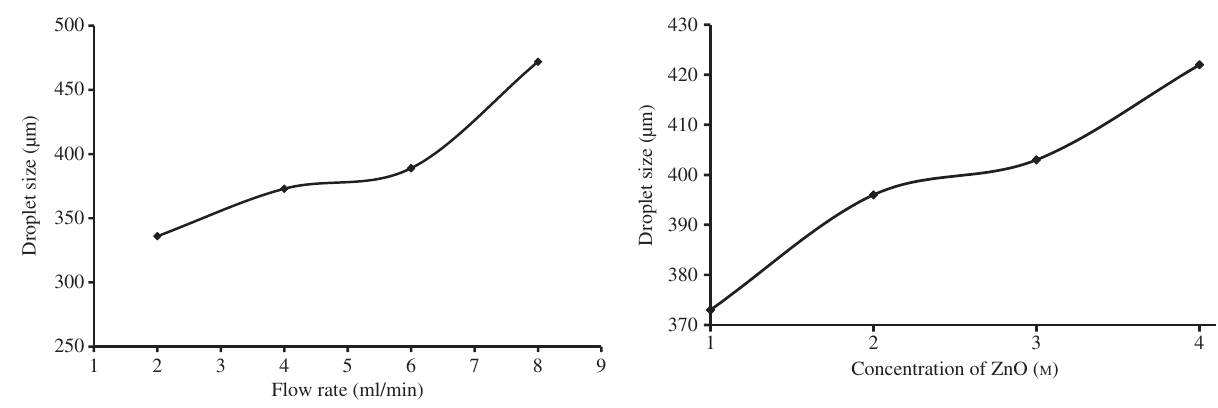
Figure 4: Effect of flow rate on droplet size (power of atomiza- tion = 39 W; precursor concentration = 0.05 m).